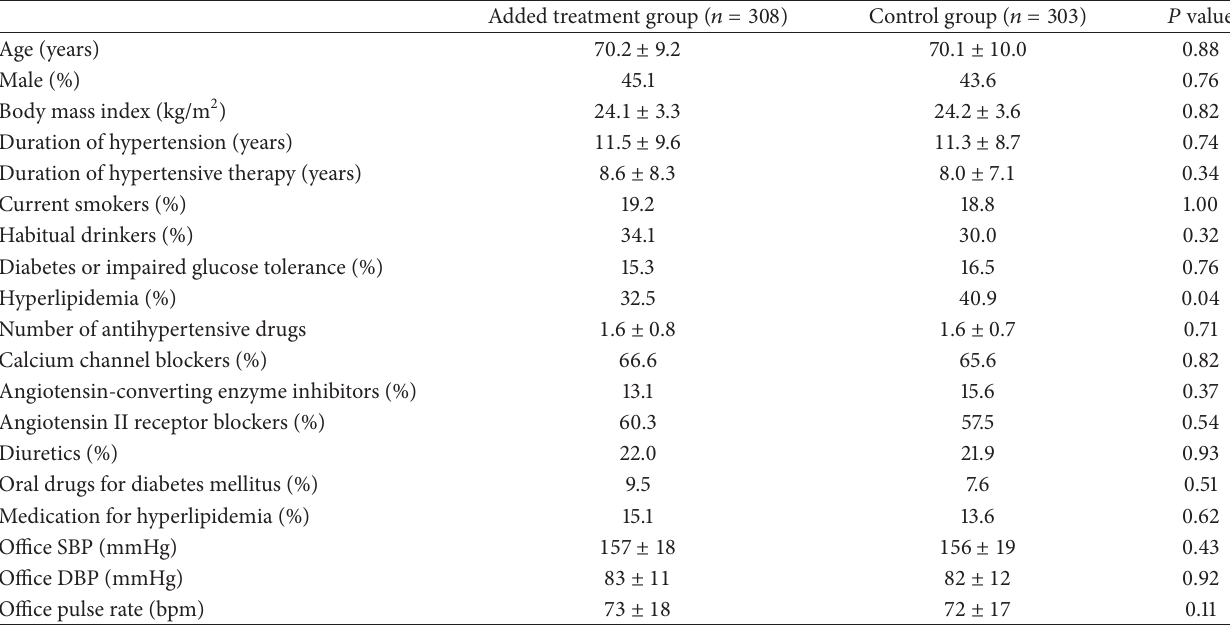
Table 1: Baseline characteristics of patients.